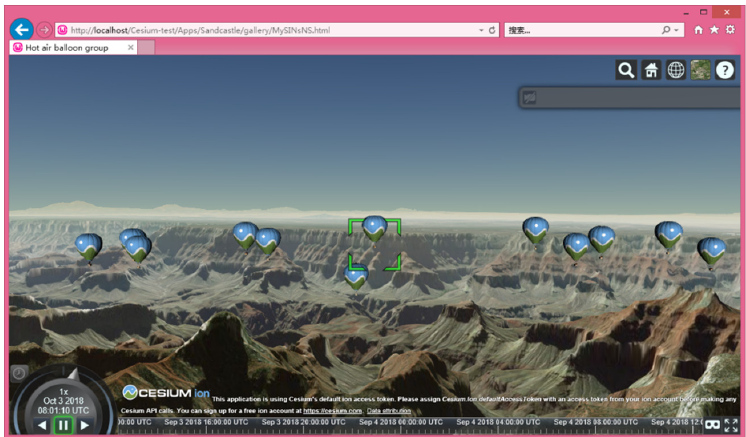
Figure 15. The 3D view display of the Near Space information system.